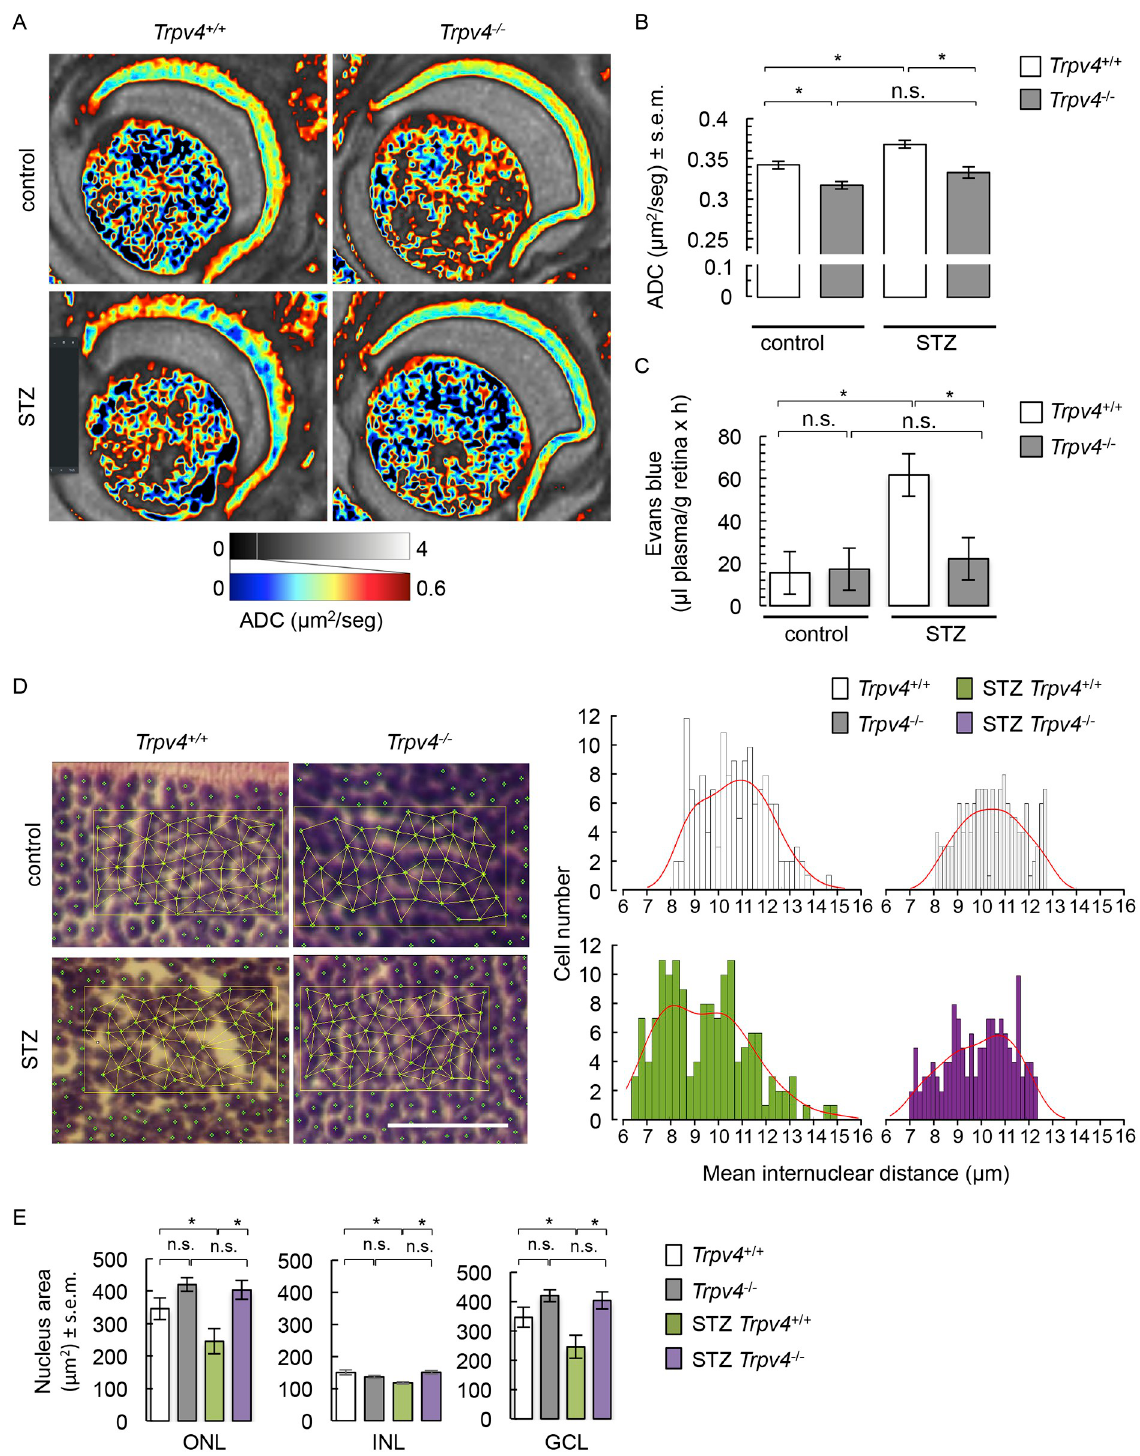
Fig 2. Water diffusion, BRB permeability, nuclear distance distribution, and nuclear area in retinas of control and STZ Trpv4 +/+ and Trpv4 -/- mice. ( A ) Representative images of ADC maps in control and STZ Trpv4 +/+ and Trpv4 -/- mouse eyes. ADC values between 0 and 0.6 μ m 2 /s are displayed in color to enhance contrast, as the retina shows markedly reduced diffusion as compared to the vitreous. ( B ) Summary of ADC values in three separate groups of control and STZ Trpv4 +/+ and Trpv4 -/- mice. ( C ) Evaluation of the Evans blue dye content in retinas from control and STZ Trpv4 +/+ and Trpv4 -/- mice. For B and C, values are mean ± s.e.m. (n = 9–12 per group). ( D ) Representative